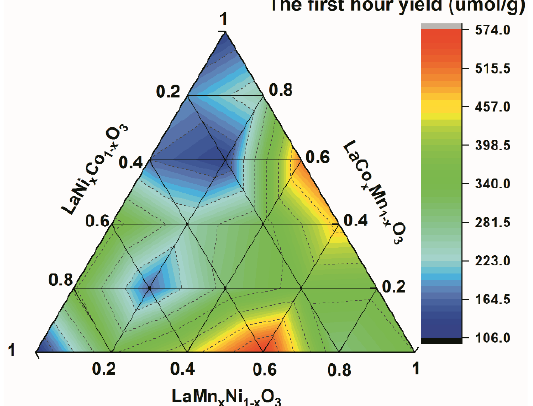
Figure 1. The first hour of CH 4 yield of LaCo x Mn 1 − x O 3 , LaMn x Ni 1 − x O 3 and LaNi x Co 1 − x O 3 (x = 0, 0.2, 0.4, 0.6, 0.8 and 1.0).